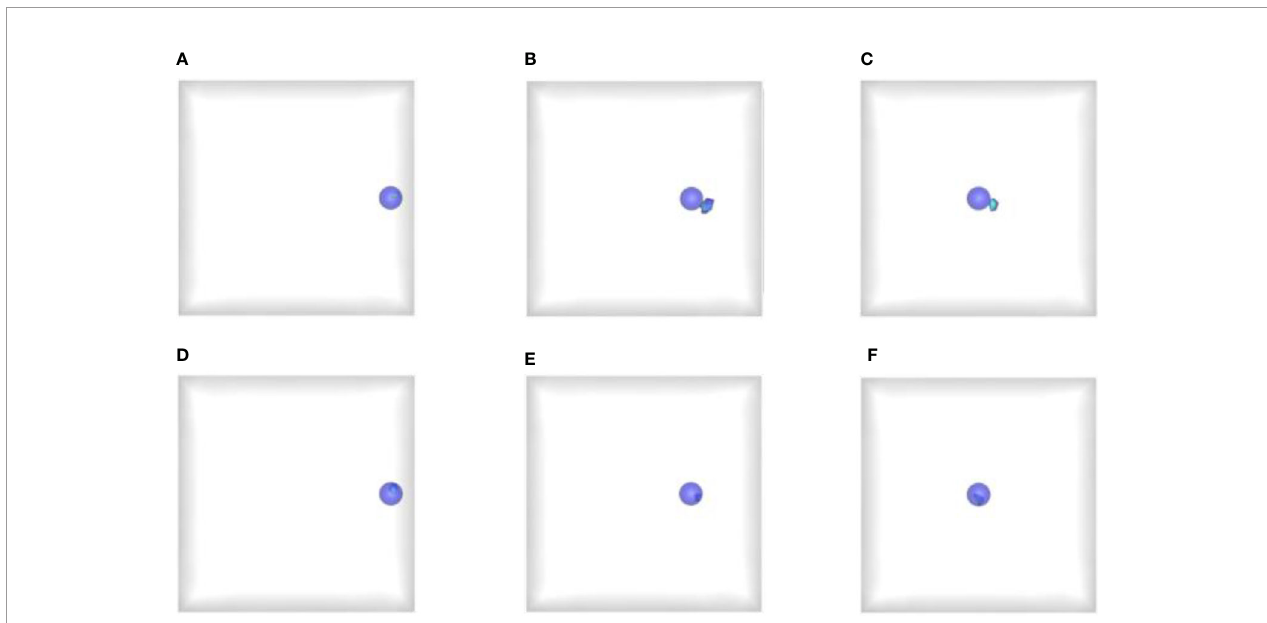
FIGURE 2 | Reconstructed results obtained by the proposed and reference methods. (A – C) The reconstructed results of the reference method at depth of 1 cm, 3 cm and 5 cm respectively; (D – F) The reconstructed results of the proposed method at depth of 1 cm, 3 cm and 5 cm respectively. The blue solid spheres mark the actual distribution of the mimic radioactive tracer, and the colored tetrahedrons are the reconstructed source.